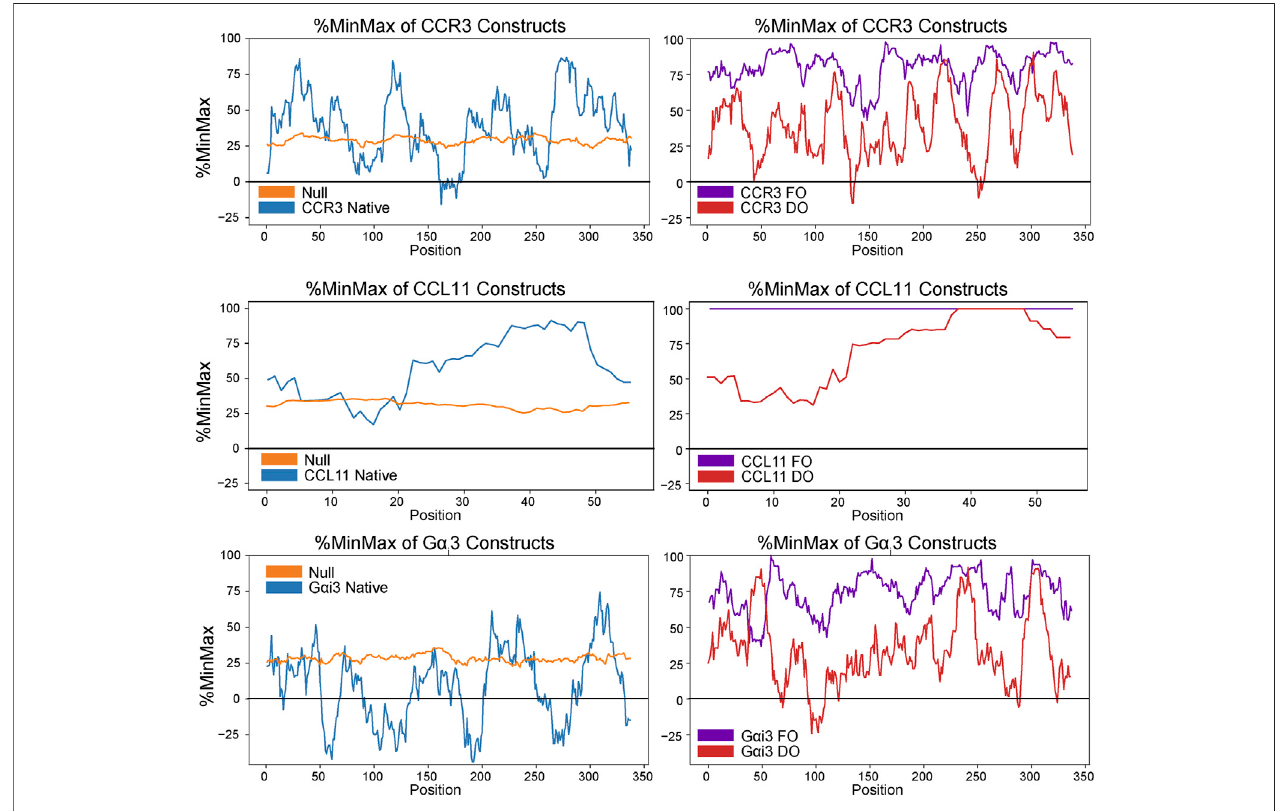
FIGURE 3 | %MinMax (Rodriguez et al., 2018) of native sequences compared to optimized heterologous sequences (FO) and constructs codon-harmonized through DUMB optimization (DO). In general, %MinMax of the DO sequences (red) more closely resemble the native values (blue) than the FO values (purple).